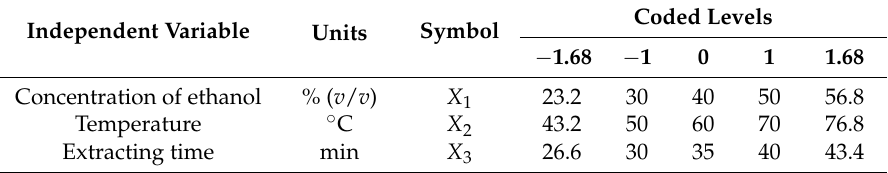
Table 1. Independent variables and their levels used for central composite design.